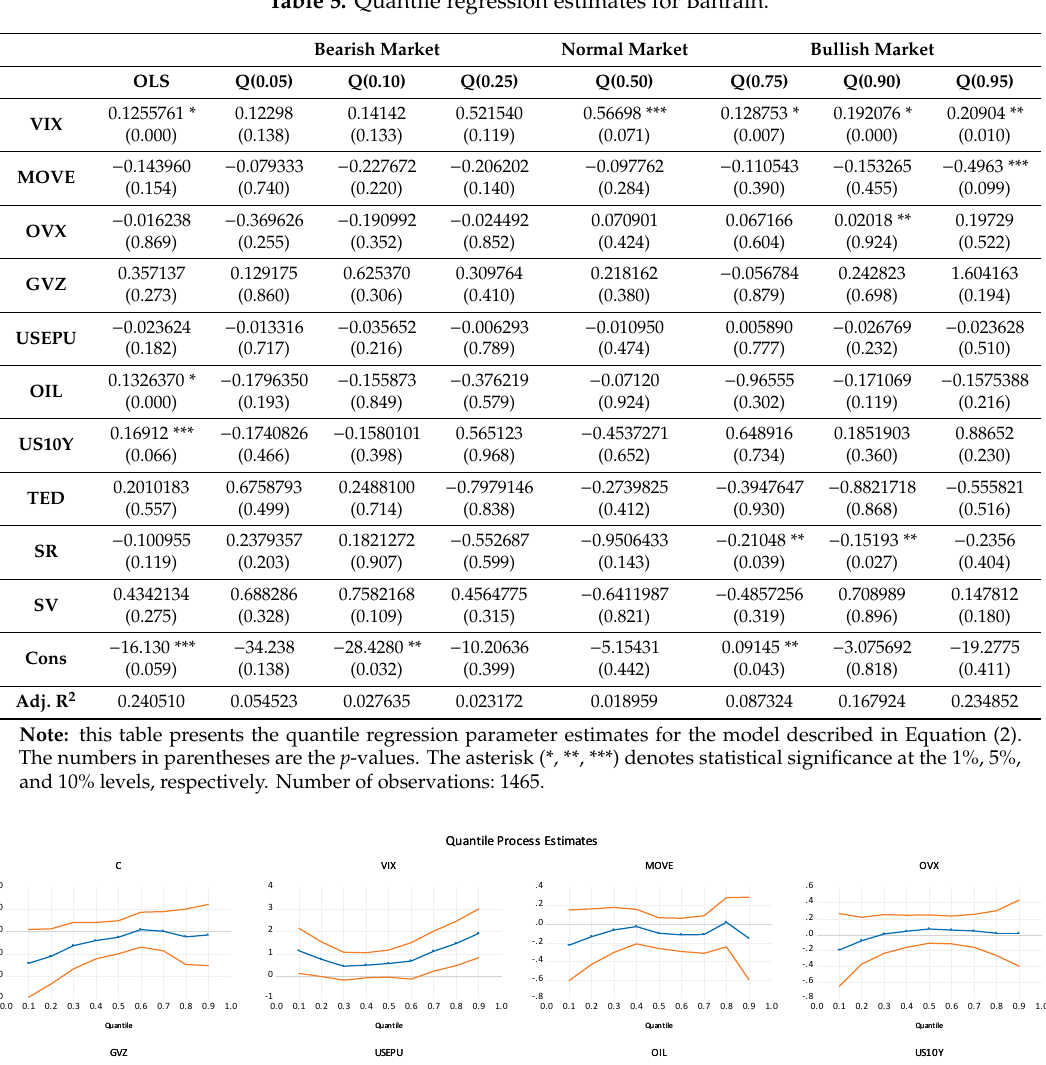
Table 5. Quantile regression estimates for Bahrain.